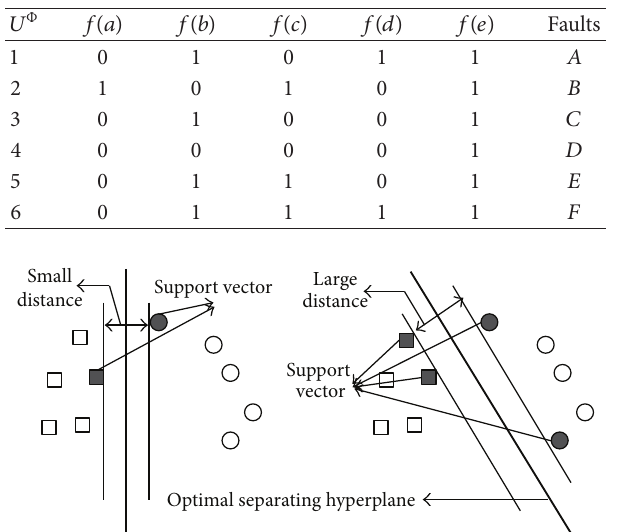
Table 1: A fault diagnosis table.